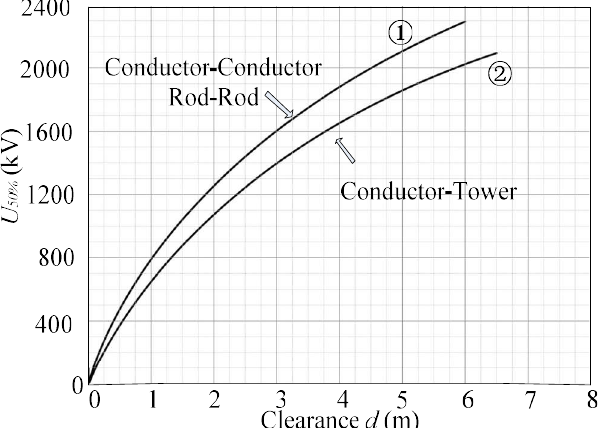
Figure 8. Flashover characteristics curve of clearance.